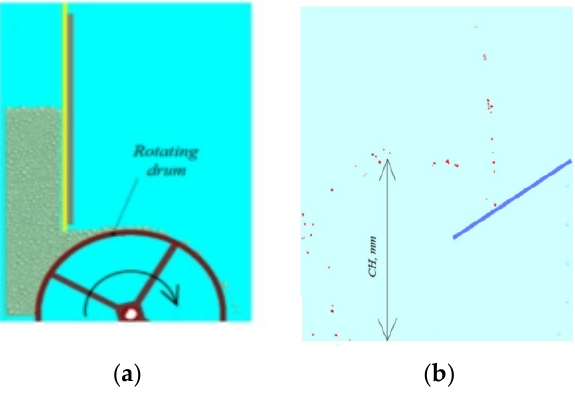
Figure 11. Particle drop test graph. ( a ) Rotation part; ( b ) Particle rebound part [105].